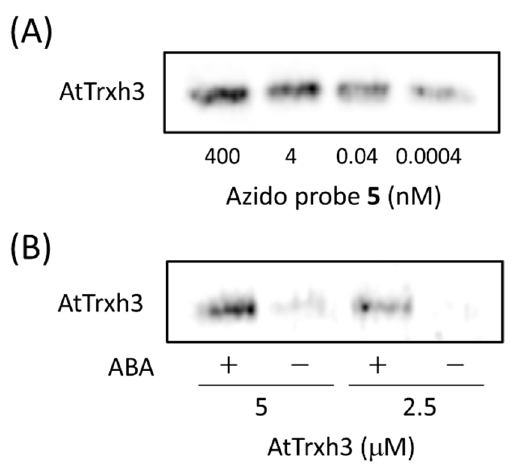
Figure 5. Evaluation of the dose-dependent effects of the concentrations of azido probe 5 and AtTrxh3 on signal intensity derived from AtTrxh3 in Western blotting. ( A ) The concentration of azido probe 5 was varied from 0.0004 to 400 nM. The concentration of linker 2 and DTSSP 4 was 40 µ M, and AtTrxh3 concentration was 5.0 µ M. ( B ) The concentration of AtTrxh3 was varied from 2.5 to 5.0 µ M. The concentration of azido probe 5 was 40 µ M, and the concentrations of linker 2 and DTSSP 4 were 40 µ M. Plus and minus signs respectively indicate the presence and absence of a 50-fold excess amount of ABA.